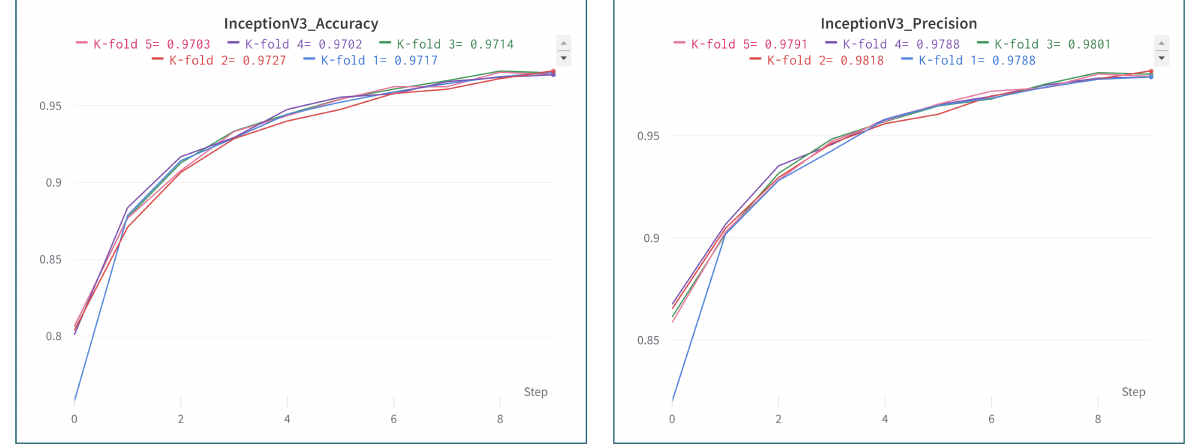
Figure 9. Training Accuracy and precision of the InceptionV3 model.